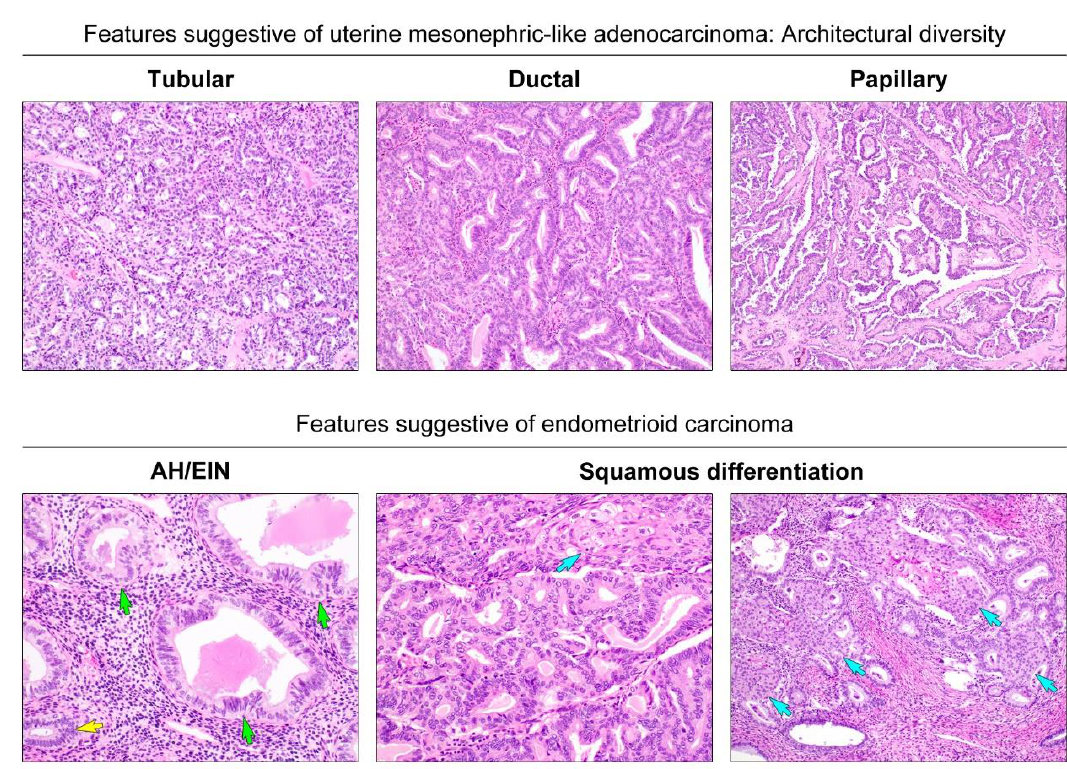
Figure 3. Histological features suggestive of either uterine MLA or endometrial EC. ( Upper panels ) Diverse growth patterns, including tubular, ductal, and papillary architecture, are suggestive of uterine MLA. ( Lower panel ) The presence of atypical hyperplasia/endometrioid intraepithelial neoplasia (AH/EIN) and foci of squamous differentiation (blue arrows) are suggestive of endometrial EC. Compared to the nuclei of non-atypical glands (yellow arrows), AH/EIN (green arrows) shows a definitive cytological demarcation, including nuclear pleomorphism, enlargement, rounding, and loss of polarity.